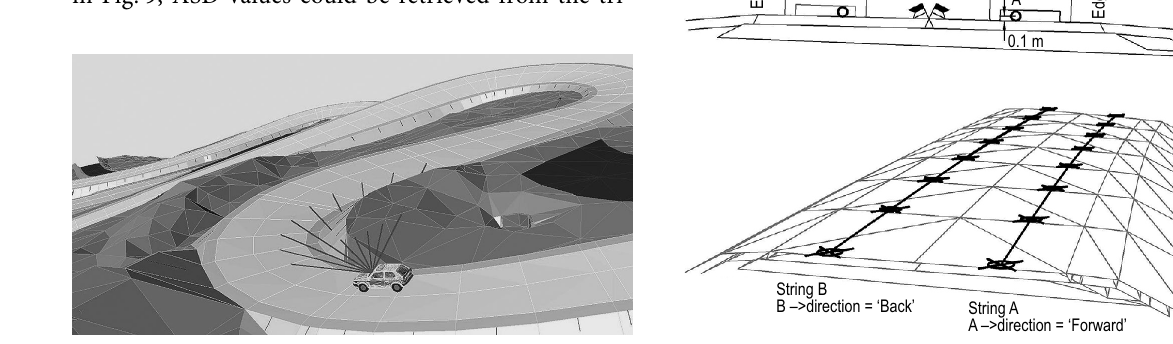
Fig. 9. Retrieving ASD from the model Fig. 10. 3D modelling for ASD analyses